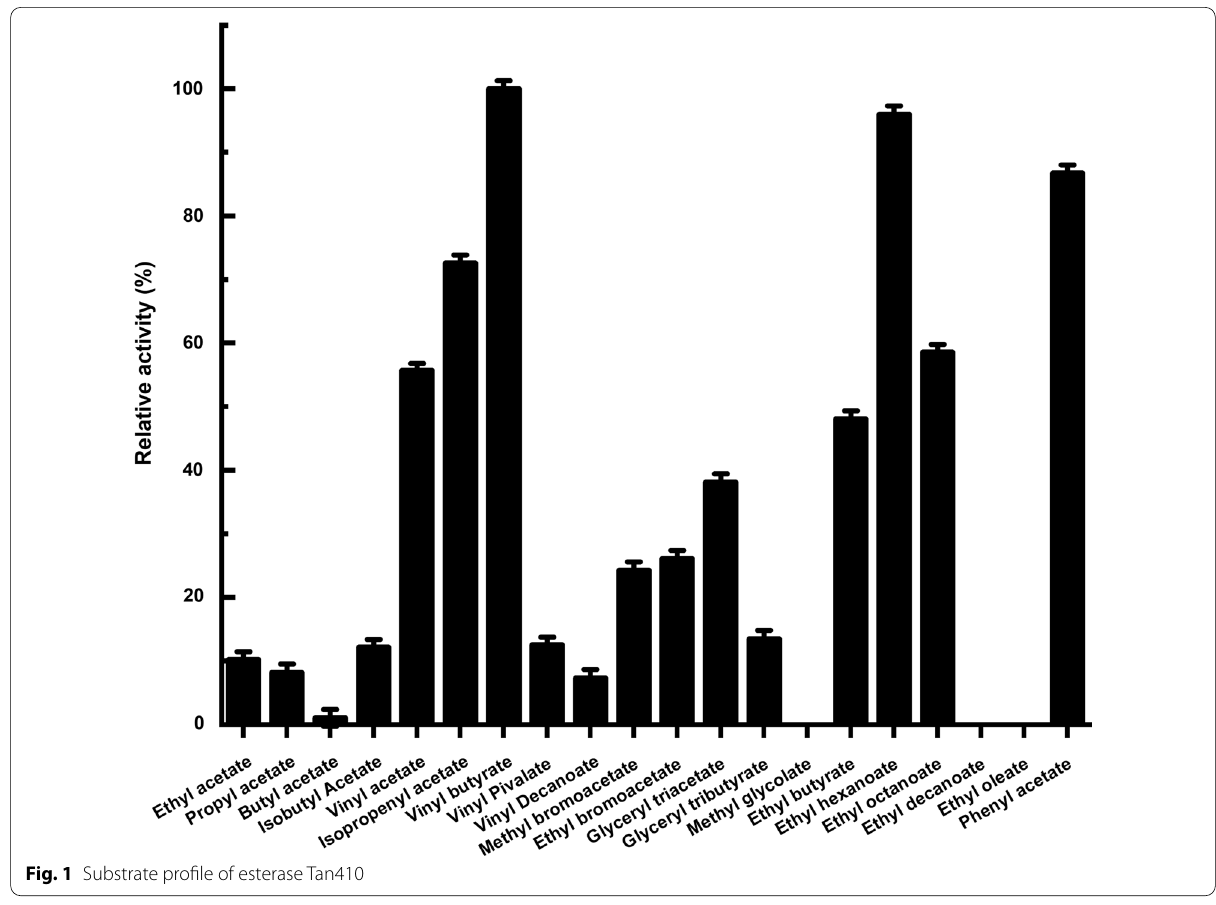
Fig. 1 Substrate profile of esterase Tan410